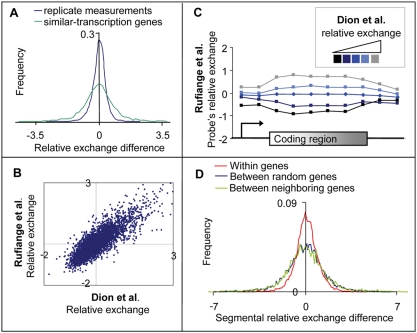
Relative exchange is a gene-specific property.(A) Distribution of relative exchange difference between genes with similar transcription rate (similar-transcription genes, green; [8]) and between replicate measurements (blue; [8]). The plot demonstrates that relative exchange differences are only partially explained by experimental noise. (B) A scatter plot showing the relationship between relative exchange calculated based on data from Dion et al. (x-axis, [7]) and Rufiange et al. (y-axis, [8]). The strong correlation indicates that total exchange is still informative even when eliminating the contribution of transcription rate. (C) The graphs represent composite profiles of probe's relative exchange from Rufiange et al., which were divided into five groups according to their relative exchange based on Dion et al. (shown in shades of blue, [7]). The length of the coding region was divided into six segment bins of equal length and the probes were assigned according to their nearest corresponding relative position. Outside of the coding region, aligned probes were assigned to 50 bp segment bins. Presented are the probe's relative exchange, averaged over all probes at the same group and the same segment bin. The plot demonstrates that relative exchange is reproducible in each small segment of the coding region. (D) The distribution of relative exchange differences between segments of the same coding region (red, denoted within genes; see Methods), between neighboring and between random genes (green and blue, respectively; presented are distances between the first segments). The variance within genes is smaller than the variance between neighboring or random genes, indicating that relative exchange is consistent along the coding region. Moreover, random and neighboring genes have similar distribution, indicating that relative exchange is a gene-specific property rather than a regional effect.